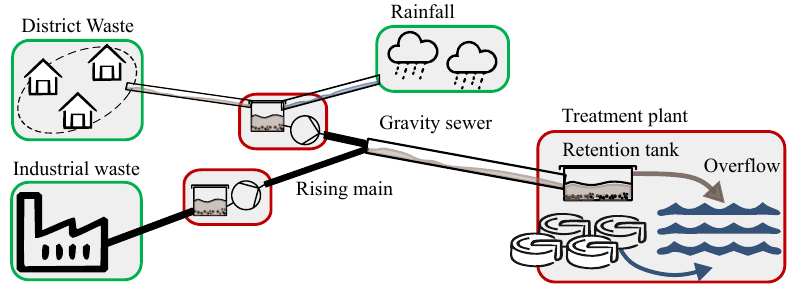
Figure 8. Sketch of a reference waste water collection with three discharge sources, district, rain, and industry, several retention tanks and a treatment